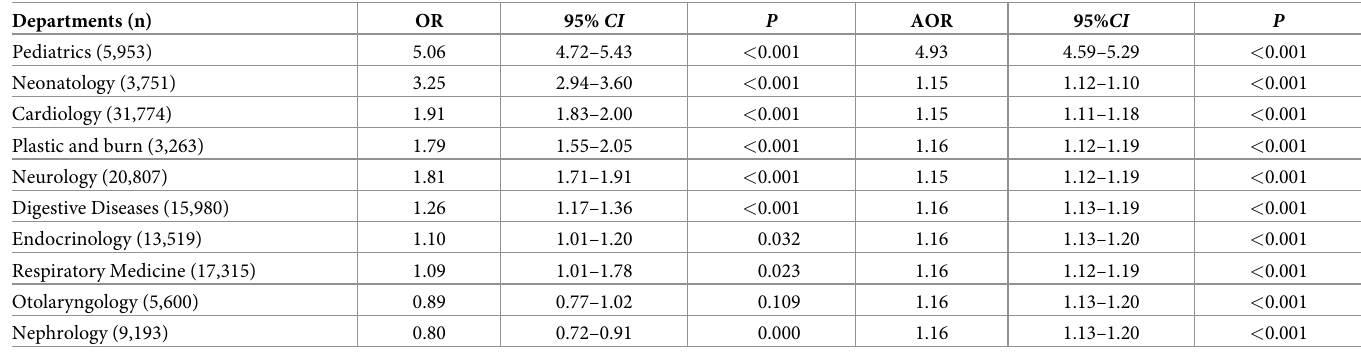
Table 3. Logistic regression analysis of the OR and the AOR of hemolysis in the top ten departments (n = 127,155). Departments